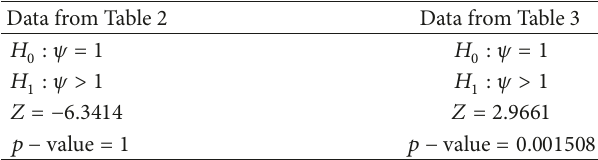
Table 5: Overdispersion